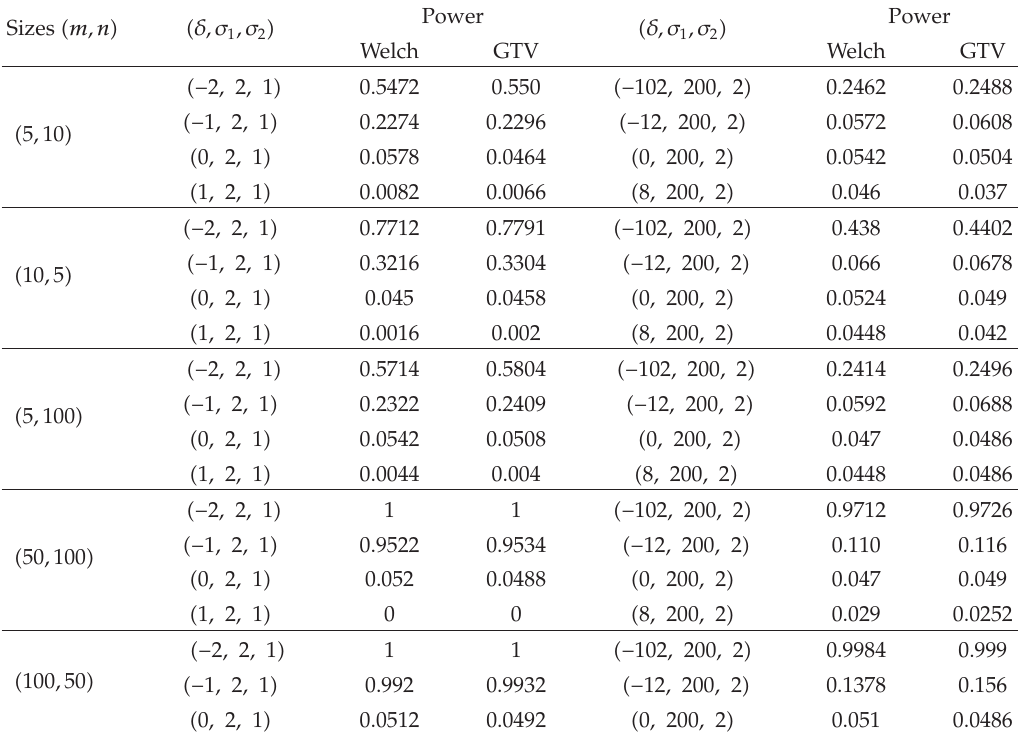
Table 7: Powers for δ (cid:2) normal case with unequal sample sizes & scale parameters (cid:3) .